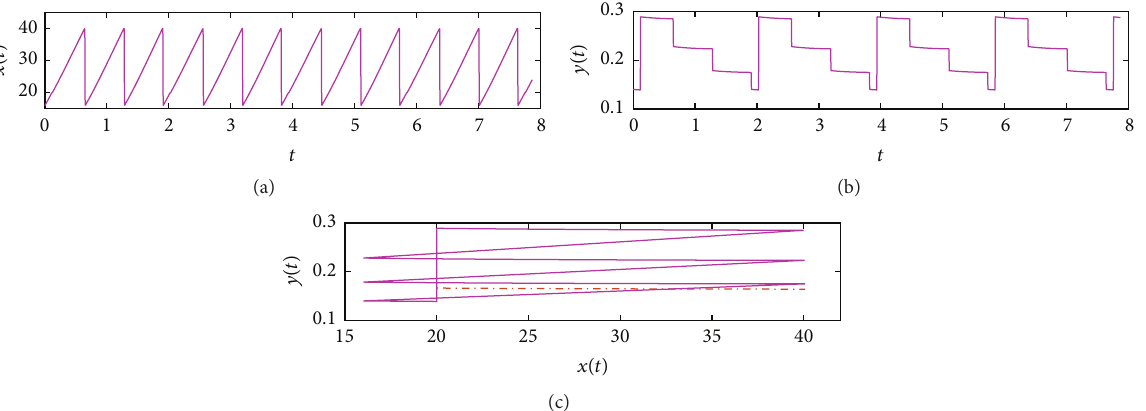
Figure 9: The change in prey density (a), predator density (b), and phase diagrams (c) starting from (𝑥 0 , 𝑦 0 ) = (16, 0.14) with 𝑝 = 0.6 , 𝑞 = 0.2 , = 20 , ℎ = 40 , 𝑦 (ℎ ) = 0.1664 , and 𝛼 ℎ 1 2 𝜏 1